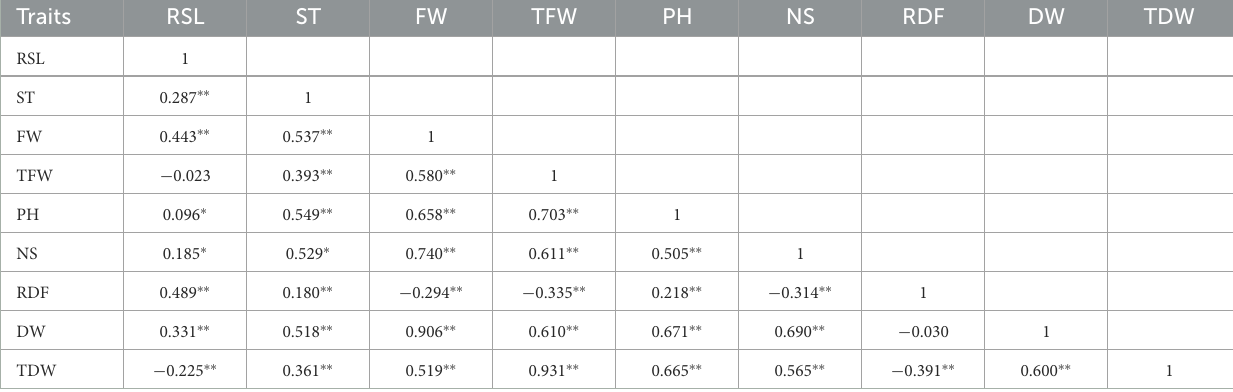
TABLE 9 Correlation coefficients of phenotypes ( rp ) among 44 varieties of alfalfa in both 2019 and 2020.